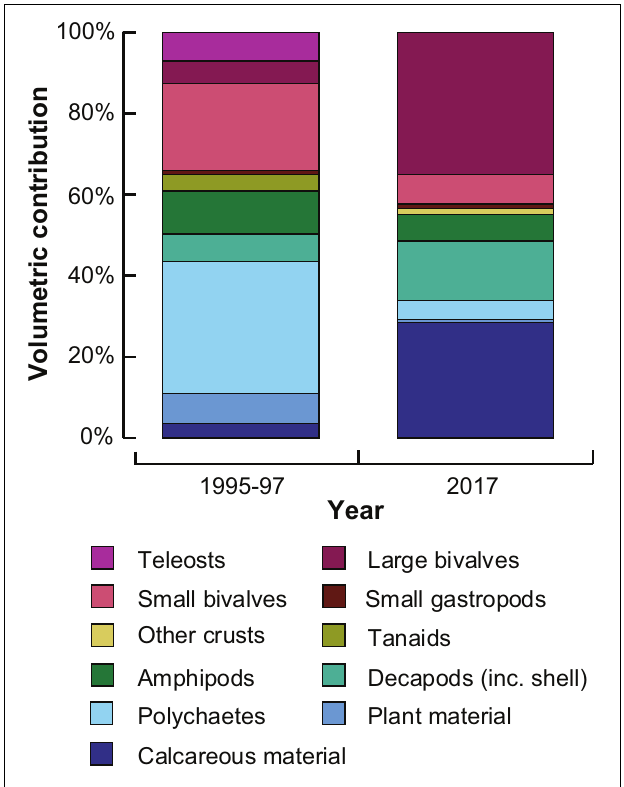
FIGURE 7 | Stacked bar graphs showing the mean percentage volumetric contribution of prey categories to the dietary composition of large ( ≥ 60 mm carapace width) inter-moult Portunus armatus in the Peel-Harvey Estuary collected between November and April of 1995/96 and 1996/97 (de Lestang et al., 2000) and in January